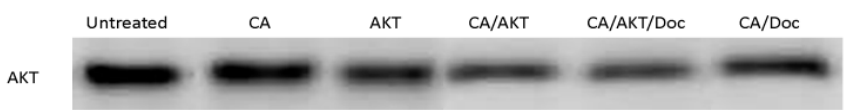
Figure 5. ERBB2 protein expression in MCF-7 cells. Cells were treated with media (untreated), carbonate apatite, free ERBB2 siRNA, CA/ERBB2 siRNA, CA/Doc/ERBB2, CA/Pac/ERBB2, CA/Doc, and CA/Pac. Ingredients include 3 mM of CaCl 2 , 1 nM siRNA, and 1 nM drug. Cellular lysates were run in SDS-PAGE and transferred into PVDF membrane and incubated with primary antibodies raised in rabbit against ERBB2. HRP-conjugated goat anti-rabbit secondary antibody was used to detect the chemiluminescent signals. 3.3. In Vivo Efficacy of CA/Drug/siRNA According to cell viability data on 4T1 cells and the enhancement in the cytotoxicity of drugs, co-delivery of AKT and ERBB2 siRNAs together with Pac or Doc resulted in the highest increase in the drug’s efficacy. Thus, these two combinations were applied in animal study. For comparison of the in vivo efficacy of the therapeutics in the first batch, animals were treated on day 8 and 11. Formulations were prepared by mixing 4 mM Ca, 1.25 mg/kg Pac, 50 nM AKT siRNA plus 50 nM ERBB2 siRNA in 100 μ L of HCO 3 -DMEM. There were no significant changes in the pattern of body weight change and also general signs and symptoms of the animals among different groups of the studies.